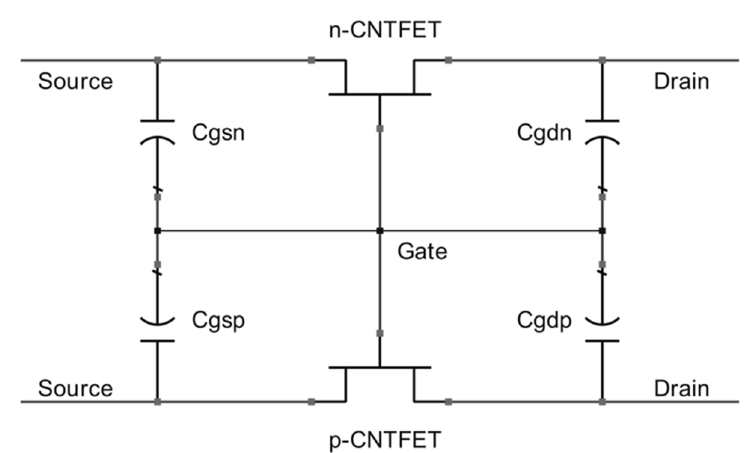
Figure 1. The equivalent circuit of the carbon nanotube field-e ff ect transistor (CNTFET) SPICE model. The CNTFET can be modeled as parallel-connected n-type and p-type CNTFETs. C gsn and C gdp and C gdn indicate the intrinsic gate-source capacitance and the gate-drain capacitance of the n-CNTFET (p-CNTFET), respectively.